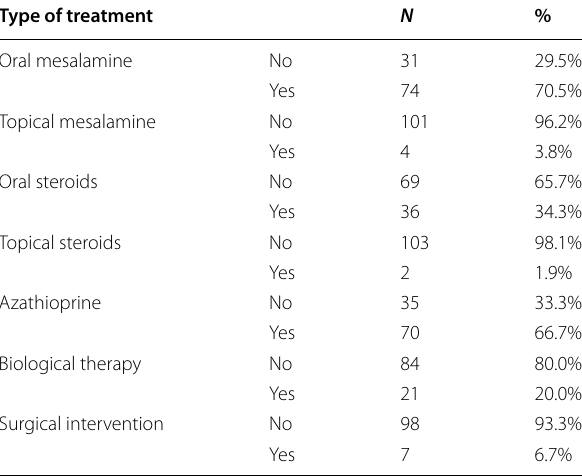
Table 7 Different types of treatment received by patients Type of treatment